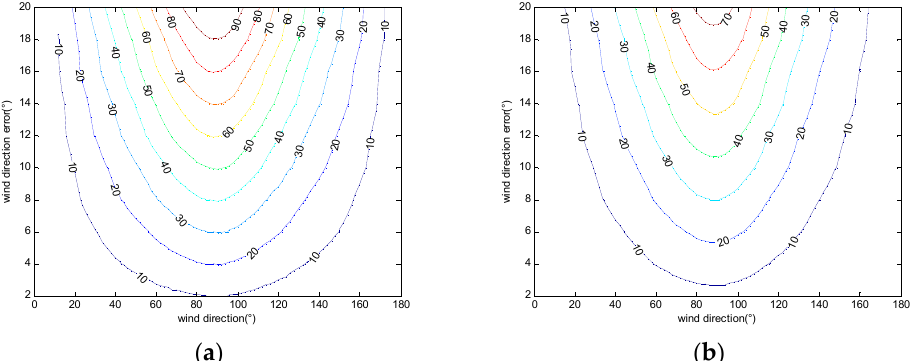
Figure 5. Surface Doppler shift errors due to different wind direction errors: ( a ) HH polarization; ( b ) VV polarization.